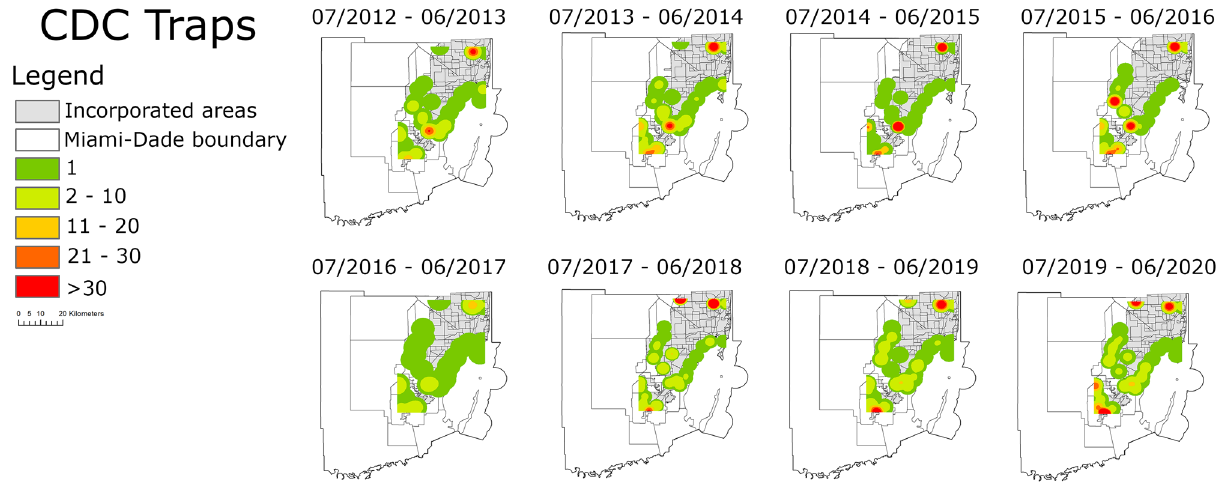
Figure 1. Heat map based on the relative abundance of species from the Culex coronator complex collected by the 32 CDC traps in Miami-Dade County, Florida from July 2012 to June 2020. The color gradient represents the sum of species from the Cx. coronator complex collected by each CDC trap in a 12 months period. The figure was produced using ArcGIS 10.2 (Esri, Redlands, CA), using freely available layers from the Miami-Dade County’s Open Data Hub—https:// gis- mdc. opend ata. arcgis.